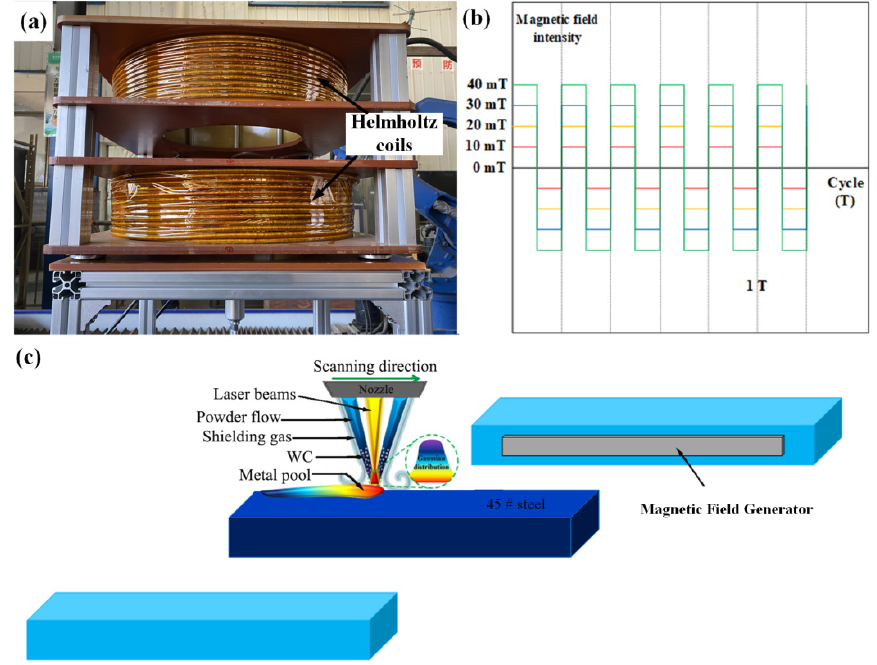
Figure 1. SEM images of ( a ) Ni60A powder and ( b ) WCPs.